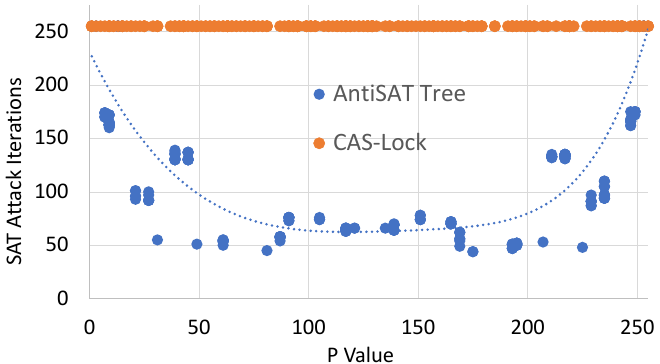
Figure 11: SAT Attack Time and Number of Iterations for CAS-Lock and Anti-SAT Structures with Varying Output-One